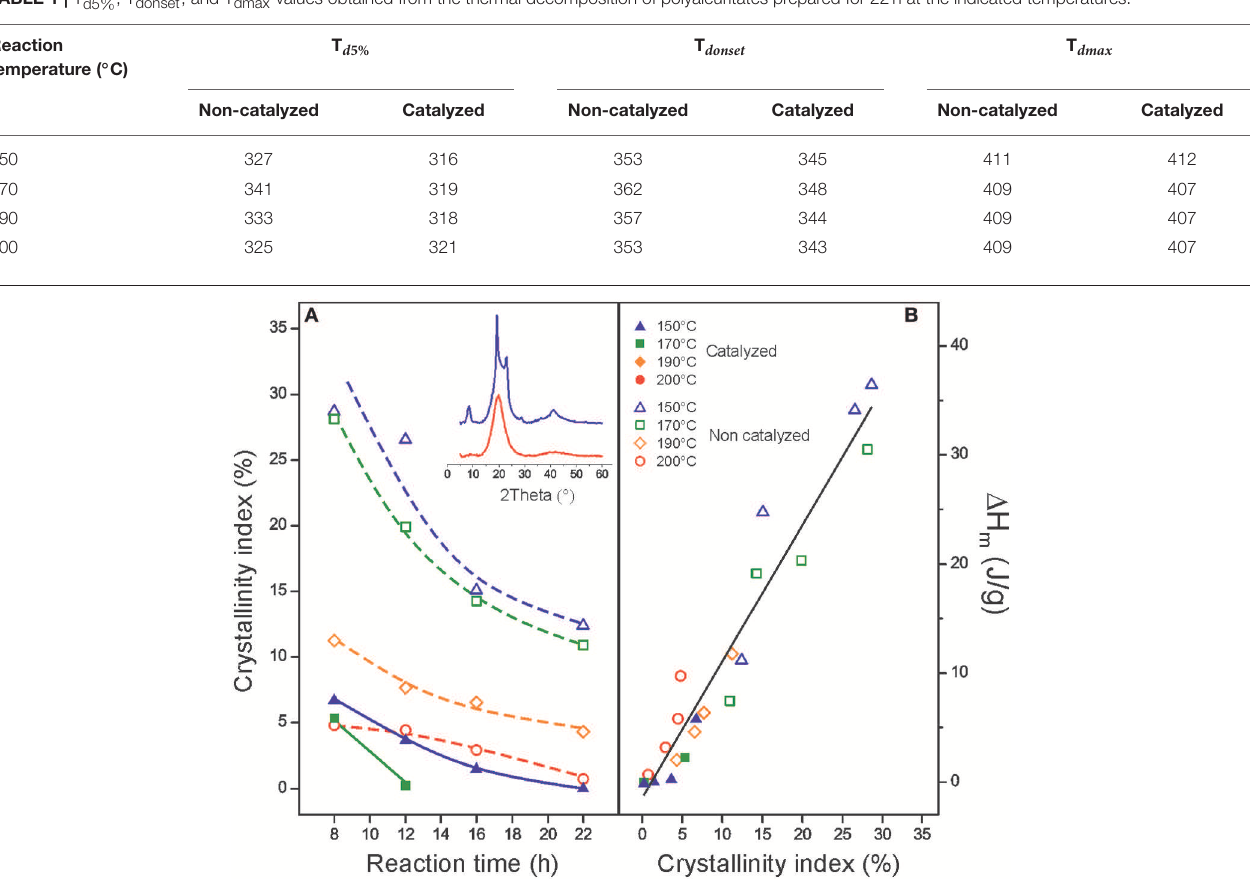
TABLE 1 | T d5 % , T donset , and T dmax values obtained from the thermal decomposition of polyaleuritates prepared for 22h at the indicated temperatures. Reaction temperature ( ◦ C)